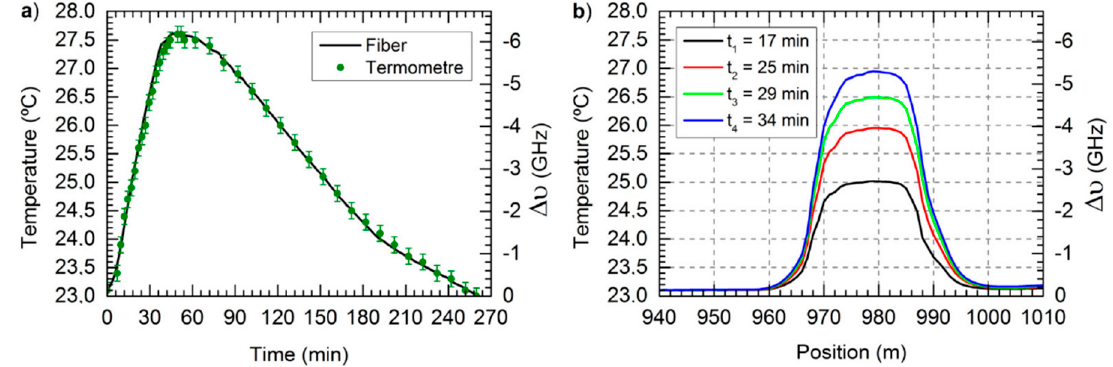
Figure 15. (From [10]) Measured temperature variations when temperature is raised from 23 °C to 27.5 °C and back to 23 °C in 20 m of fiber around meter 979 of the FUT, over 270 min. ( a ) Temperature evolution of meter 979 along time ( b ) Temperature profile along 70 m of fiber at different times. @2016 The Optical Society [10]